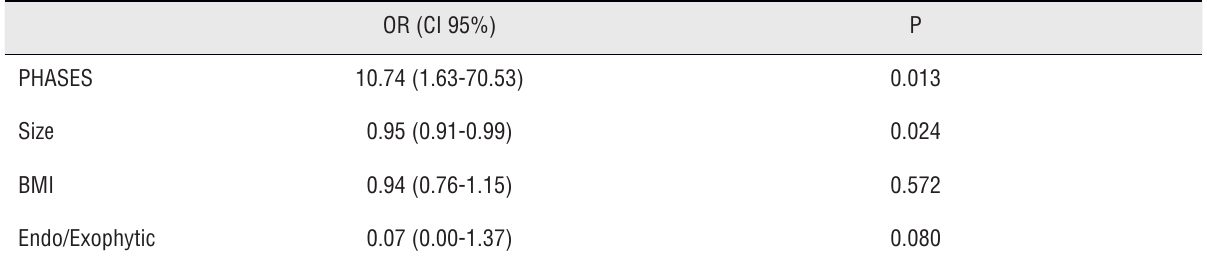
Table 4 - Multivariate logistic regression (outcome: to reach 25 min.